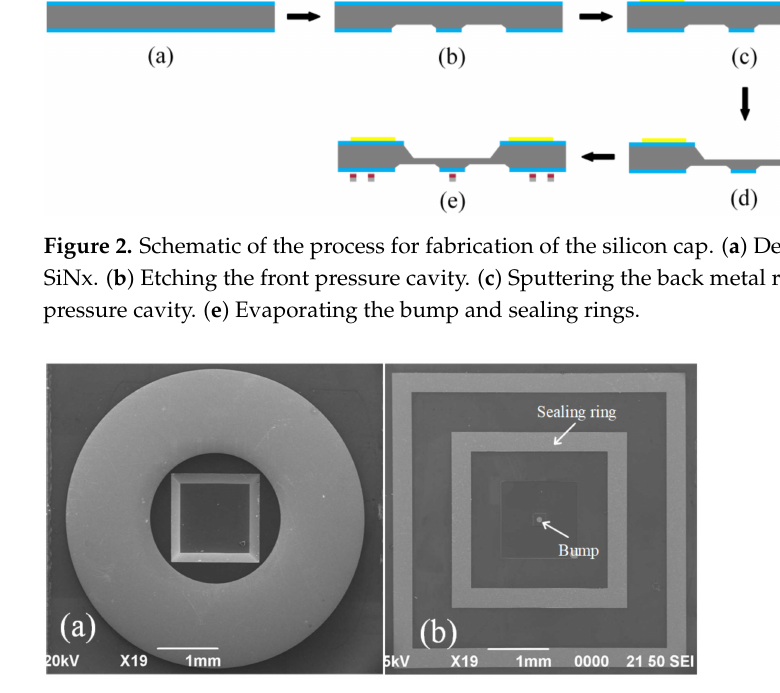
Figure 3. SEM images of the silicon cap. ( a ) Backside. ( b )